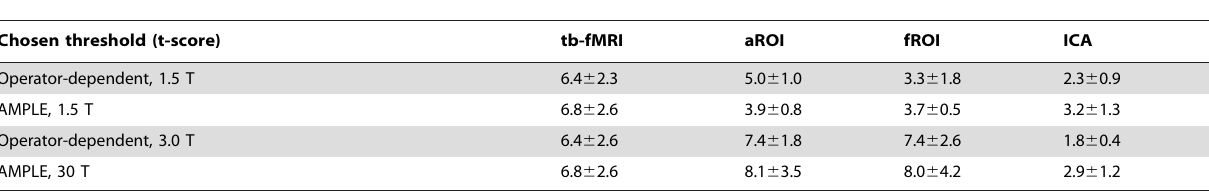
Table 3. Chosen thresholds for each method and scanner.